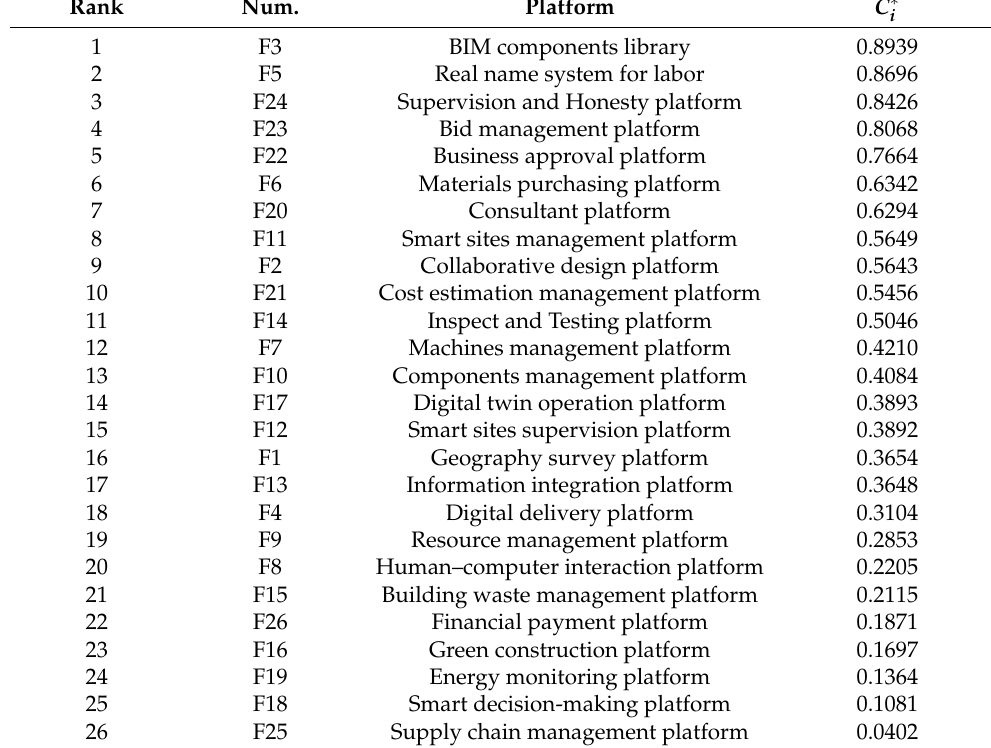
Table 7. The rank of the